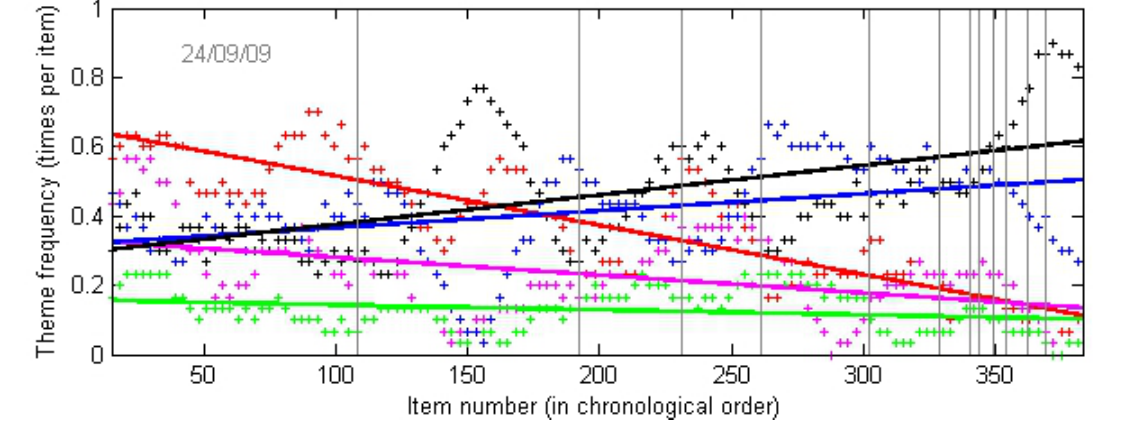
Fig. 7. Theme frequency plot for online discussion platform. Horizontal axis is the item number; items were plotted in chronological order (intervals within gray lines represent 1 day), vertical axis is the count frequency for each theme (moving average over 30 items centered on item i). Lines are best-fit linear trends for different themes. Vertical gray line represents 1